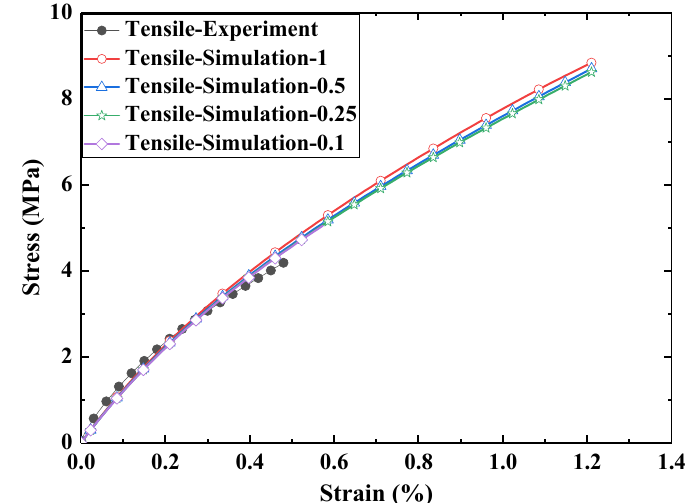
Figure 15. Comparison of stress relaxation with experimental data.